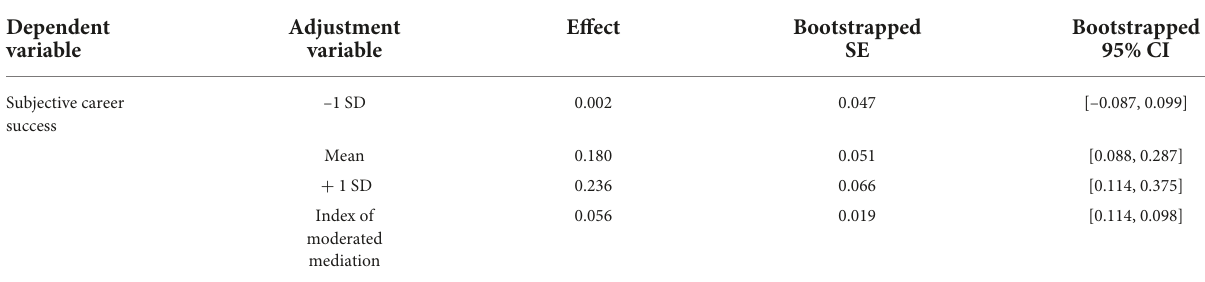
TABLE 7 Results of conditional indirect effects.